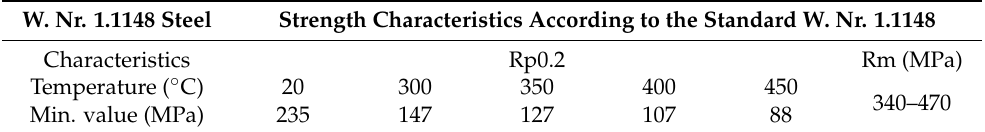
Table 1. Standard strength characteristics of steel W. Nr.